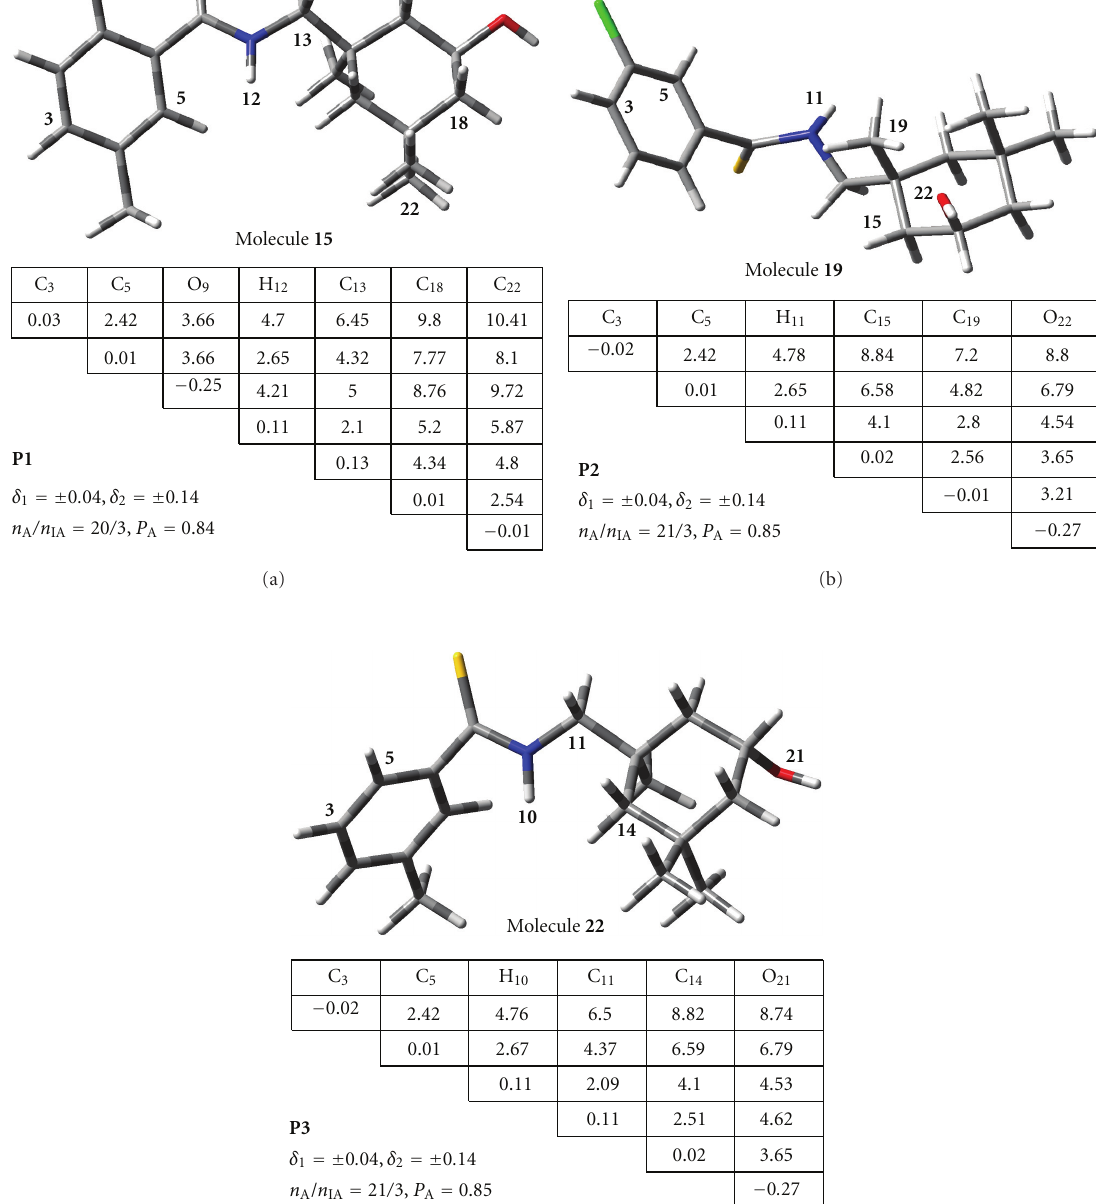
pharmacophore structure, the active feature 2 , P2 , consists of the 6 atoms (C 3 , C 5 , H 11 , C 15 , C 19 , and O 22 ). Molecules 15 and 22 were chosen as templates and compared with the rest of the molecules in the series. Phar- macophore 1 ( P1) was found in 20 of 30 active molecules having the probability P A = 0 . 84 and pharmacophore 3 ( P3) were found in 21 of 30 active molecules having the probability P A = 0 . 85 as seen in Figure 3 and statistical estimates for the pharmacophores are given in Table 2. heterocyclic rings. It is quite possible that the atoms